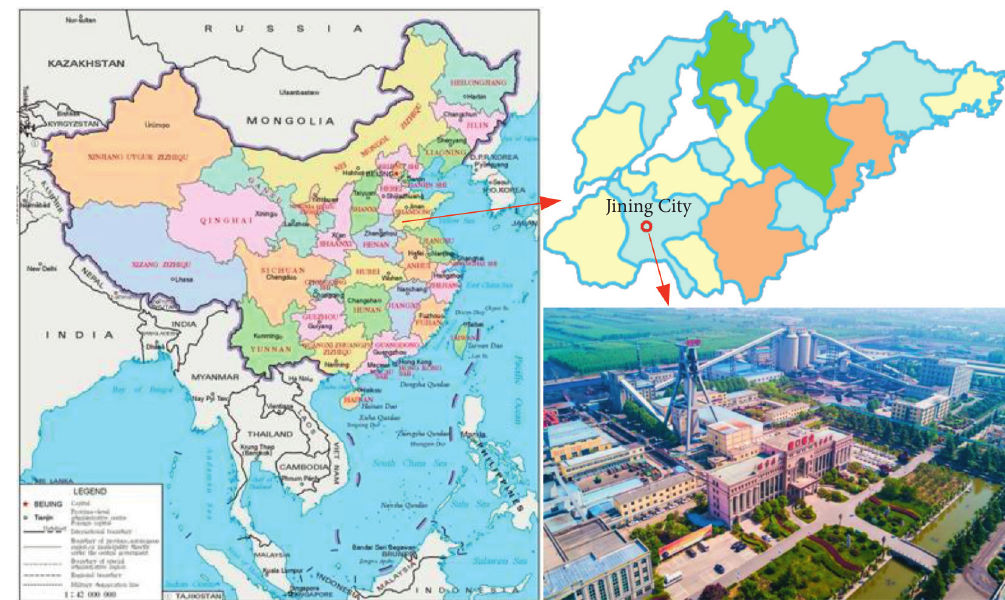
Figure 1: Location of tangkou coal mine.